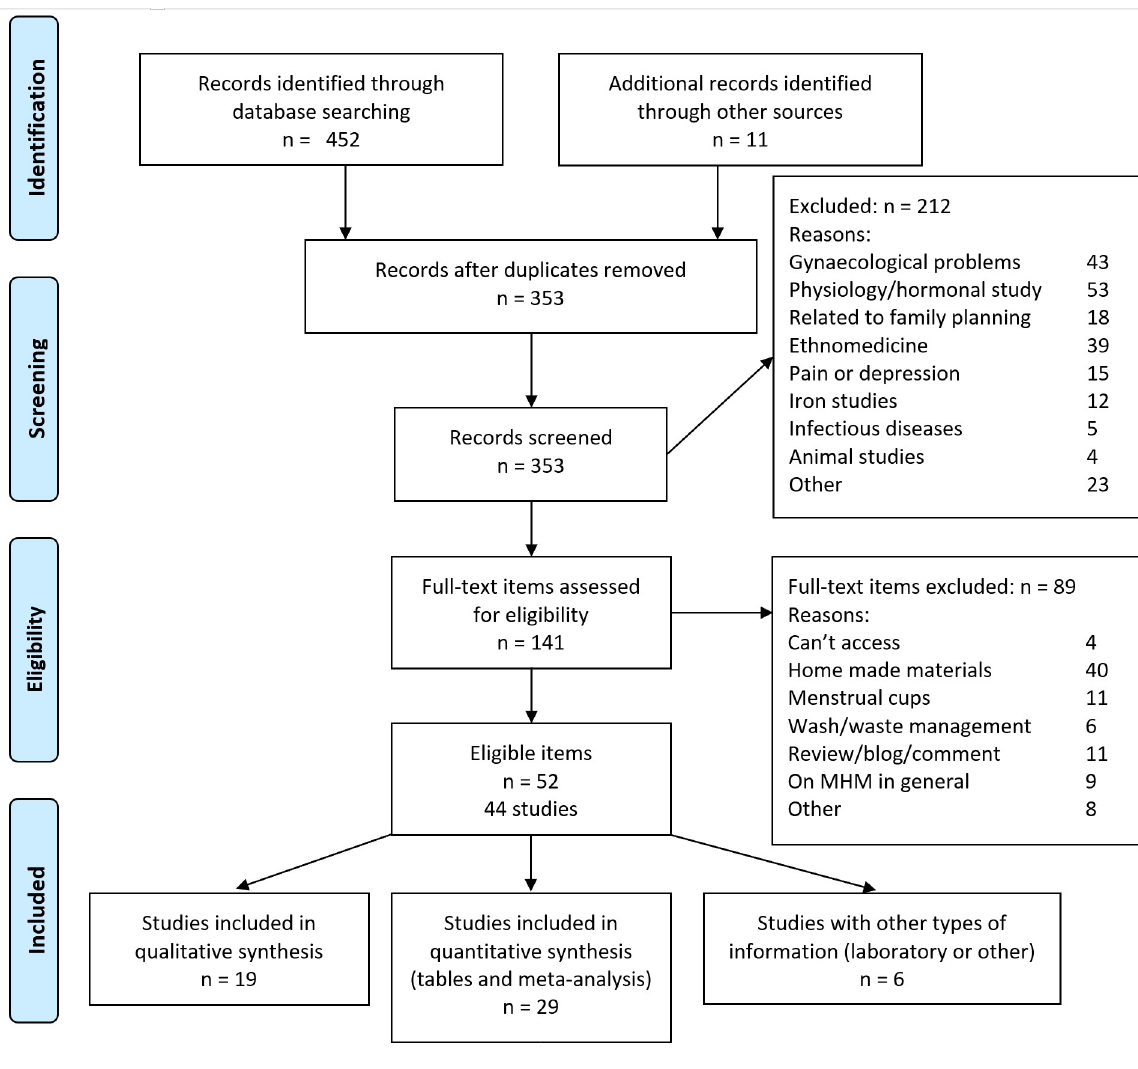
Fig 1. PRISMA flow